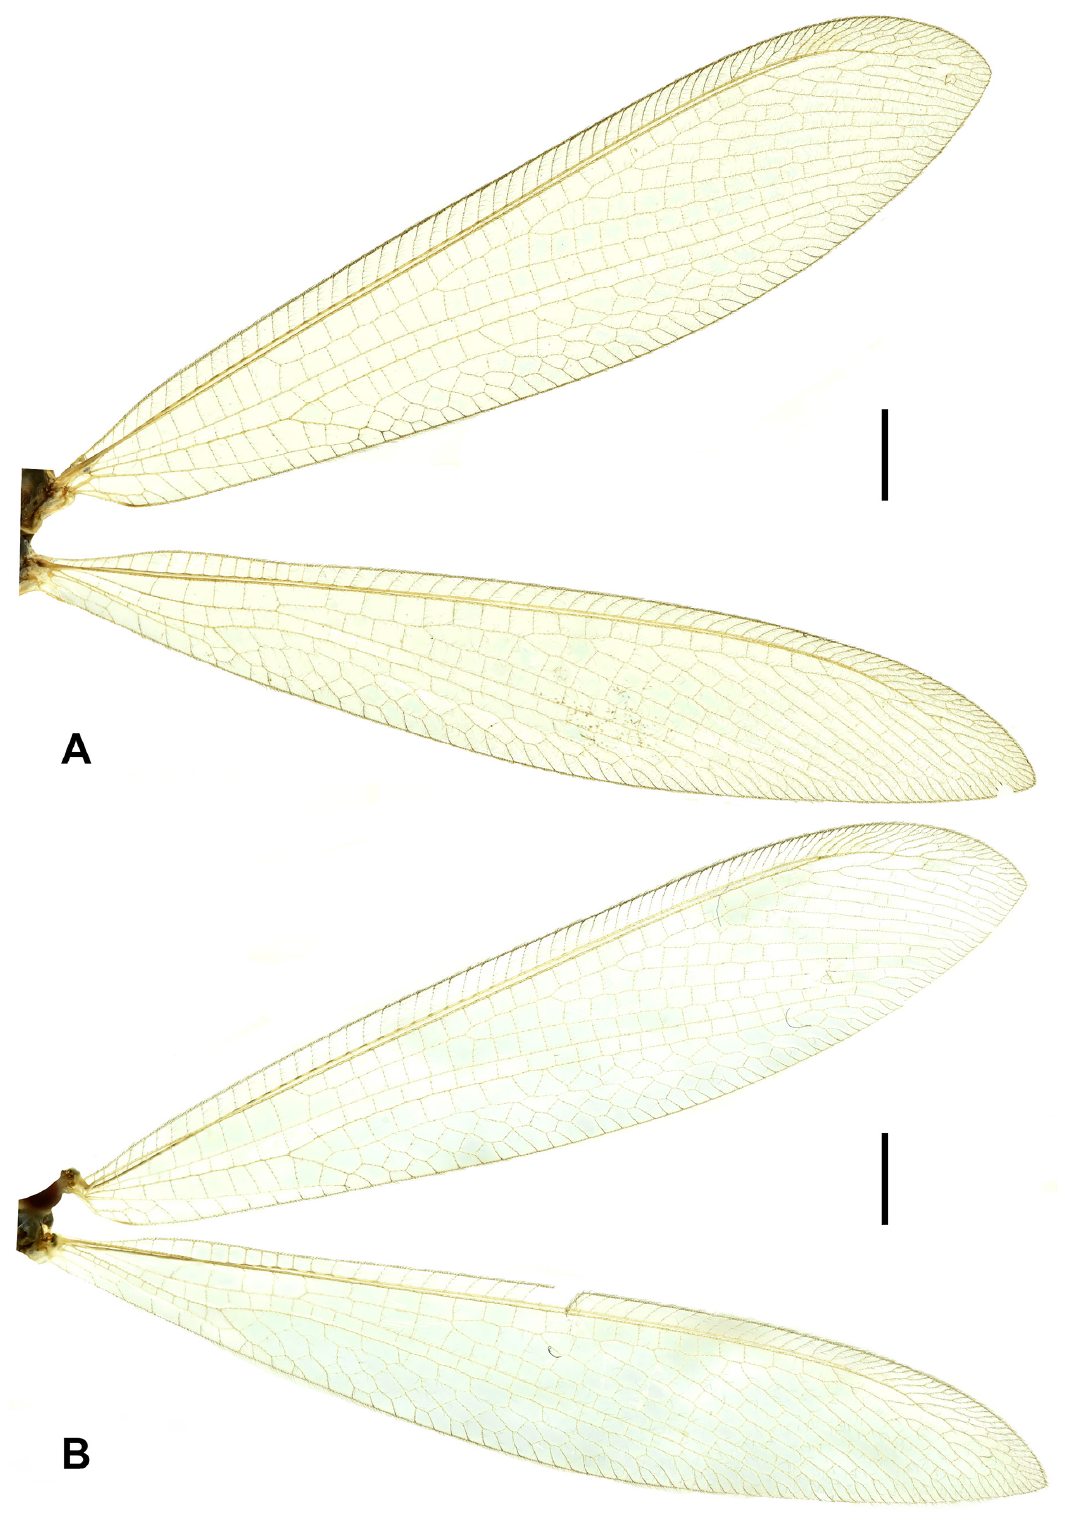
Fig. 7. Myrmeleon tenuipennis Rambur , 1842. Right fore- and hind wing. A . Male (CAUPK000010). B . Female (CAUPK000011). Scale bars = 2.0